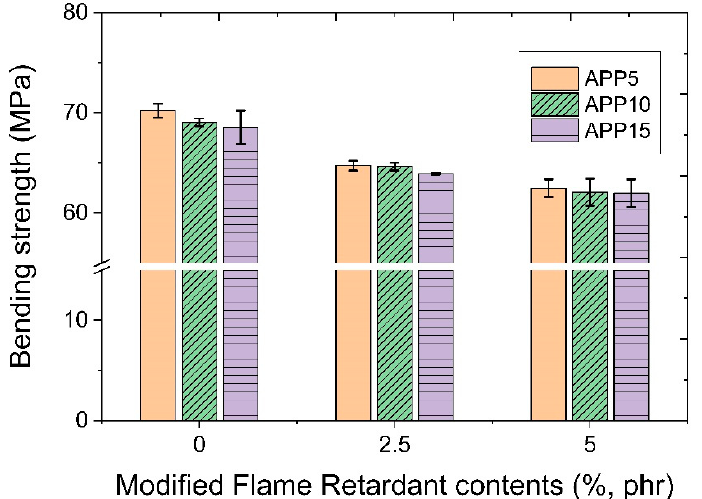
Figure 14. Bending strength characteristics as a function of the amount of modified flame retardant and APP added.